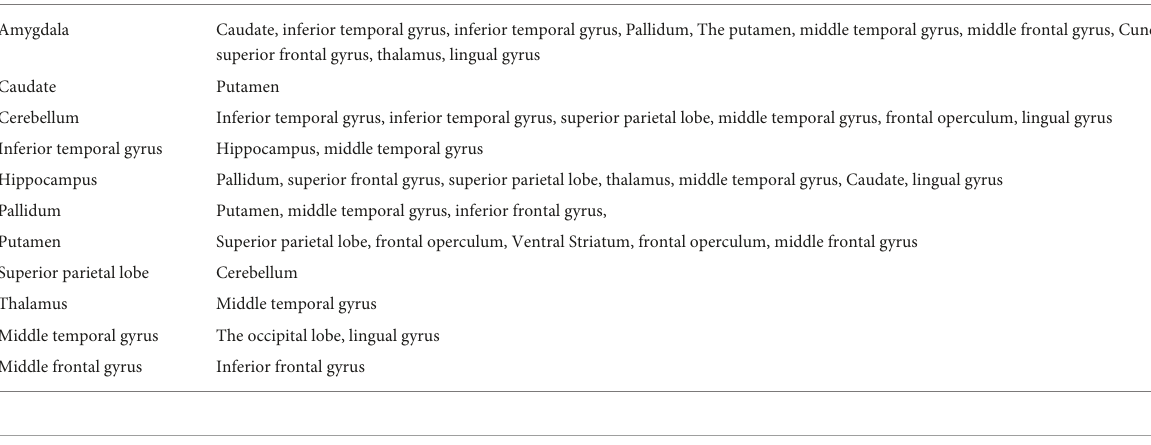
TABLE 2 The generated links as the result of neurofeedback, obtained by the CCMTF method. Nodes